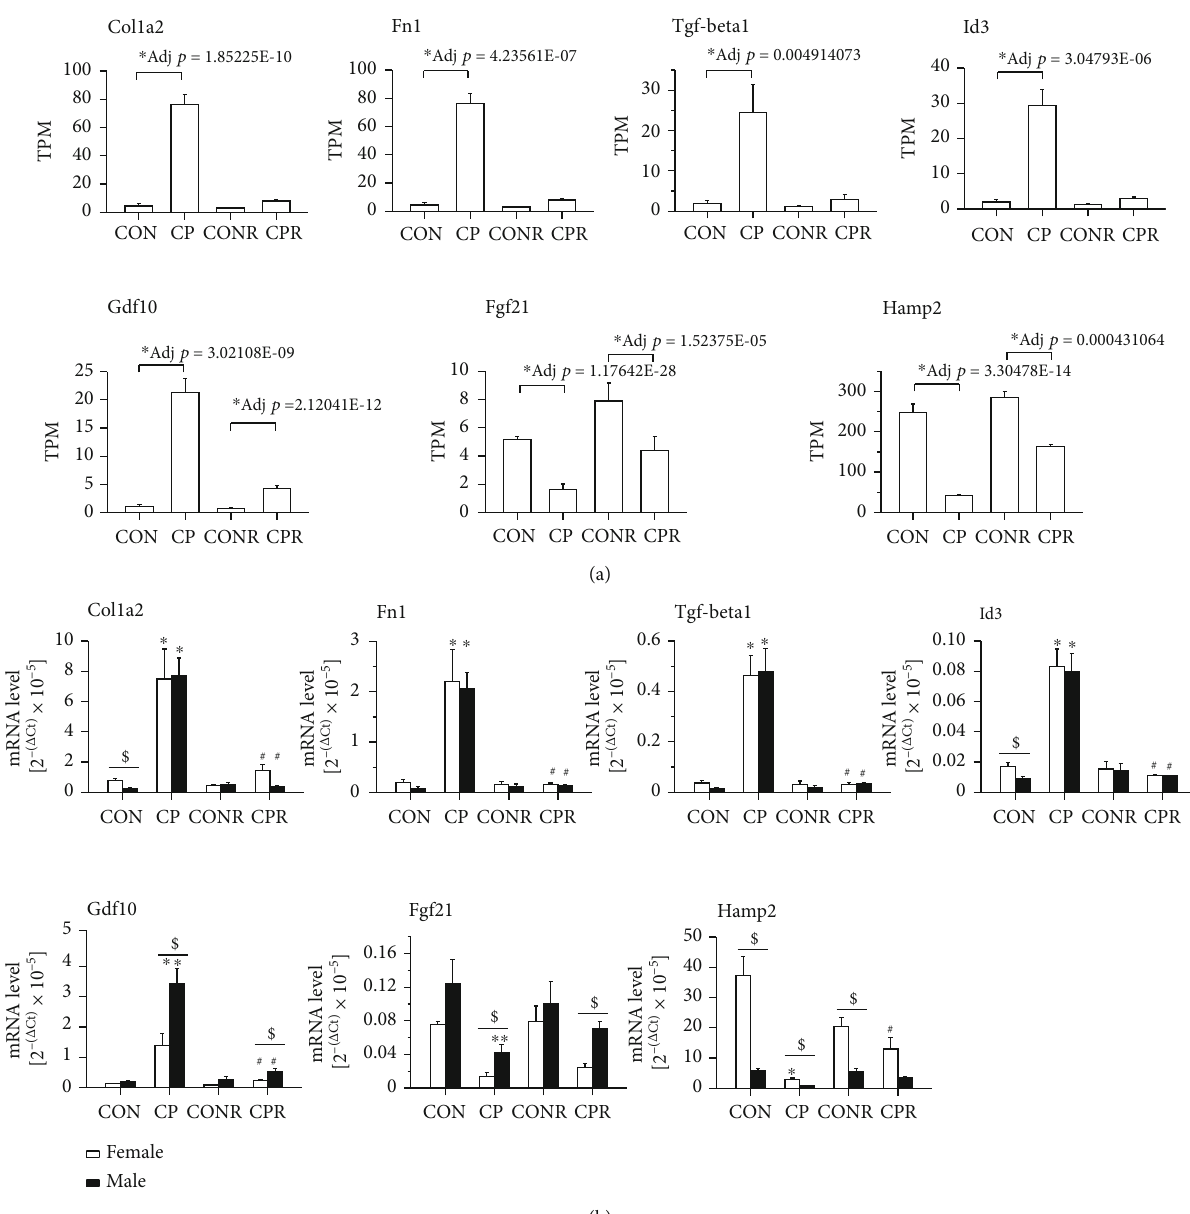
Figure 3: Validation of the selected DEGs from the RNA-seq data by qPCR. (a) The expression levels of the selected DEGs from RNA-seq data. TPM: transcripts per million. RNA-seq data are presented as mean of TPM ± SEM . n = 4 mice/group. ∗ p < 0 : 05 compared between CON and CP, between CONR and CPR. (b) The mRNA level of speci fi c genes by qPCR. The qPCR data are presented as ½ group meansof 2 − ð Δ Ct Þ ± SEM (cid:2) × 10 − 5 . n = 3 − 6 mice/group. ∗ p < 0 : 05 compared between CON and CP or CONR and CPR. # p < 0 : 05 compared between CP and CPR. $ p < 0 : 05 compared between female and male of respective